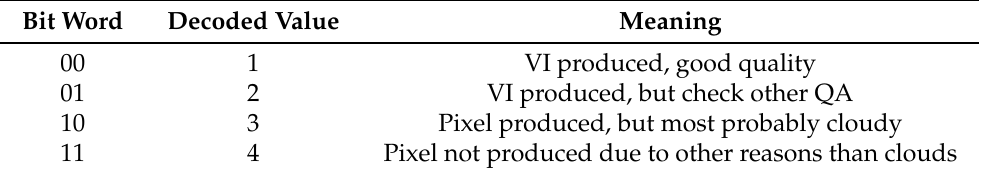
Table 1. Per-pixel MODLAND-QA parameters in the MOD13A2 “1_km_16_days_VI_Quality” layer, bits [0–1]. Bit